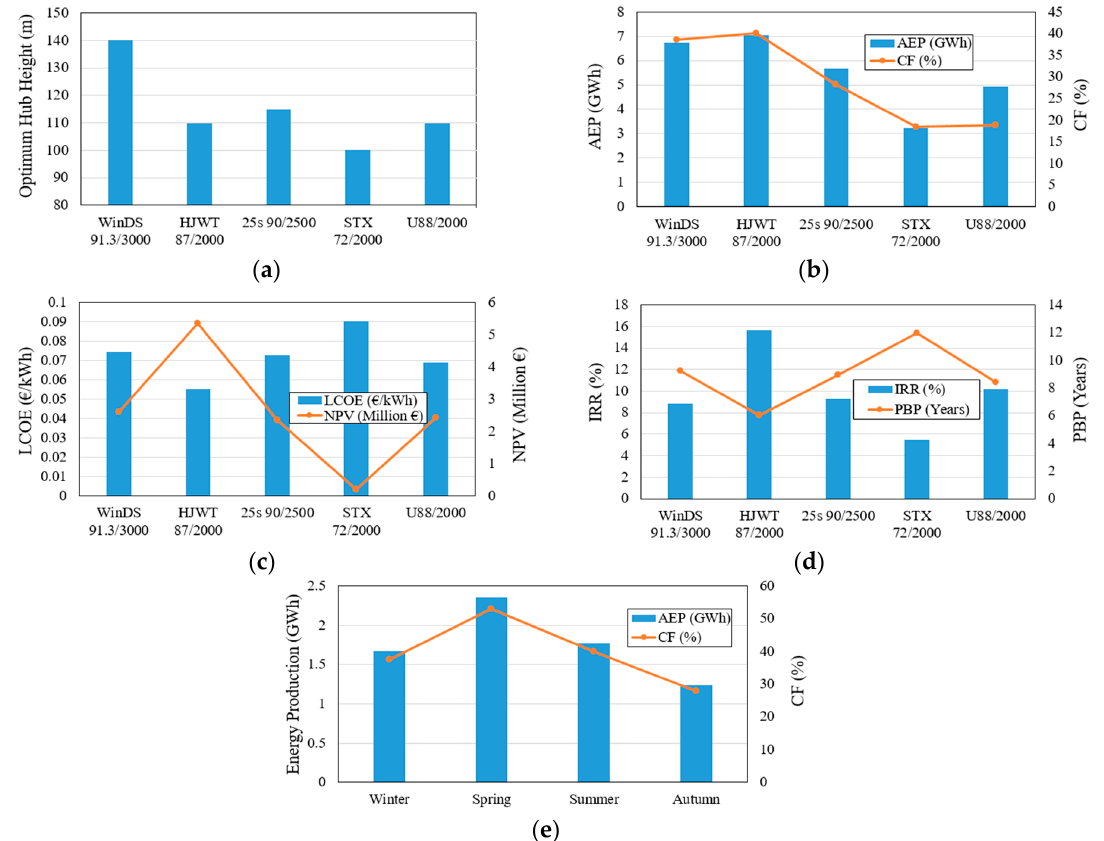
Figure 14. Effect of hub height on wind turbines economics at discount rate of 5% for Seo-San ( a ) WinDS 91.3/3000; ( b ) HJWT 87/2000; ( c ) 25s 90/2500; ( d ) STX 72/2000; ( e ) U 88/2000.